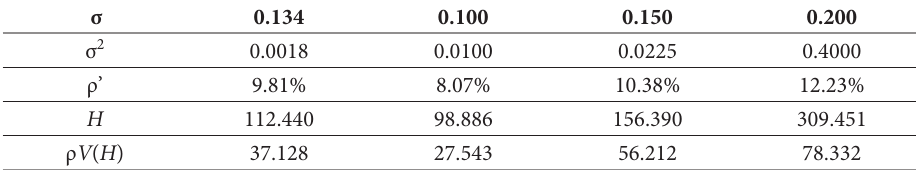
Table 5. Sensitivity analysis of the variance of net annual returns of the investment *